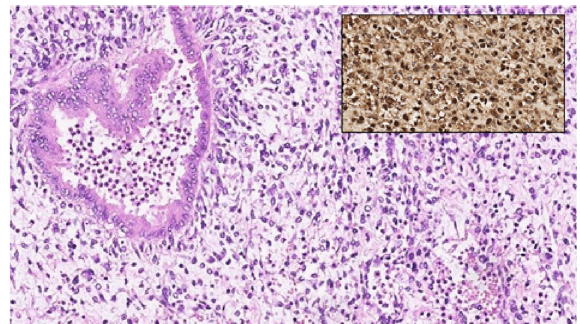
Figure 7: Histopathological exam demonstrating fusiform, oval, or stellate tumor cells distributed over myxoid or fi brous stroma. Nuclear pleomorphism and hyperchromasia are noted. Cell cytoplasm is granular and eosinophilic, with ill-de fi ned cell borders. In the top left, the remnant bile duct is involved by neoplastic cells (H&E, 20x objective). Image insert: strong and di ff use immunostaining for alpha 1-antichymotrypsin (40x